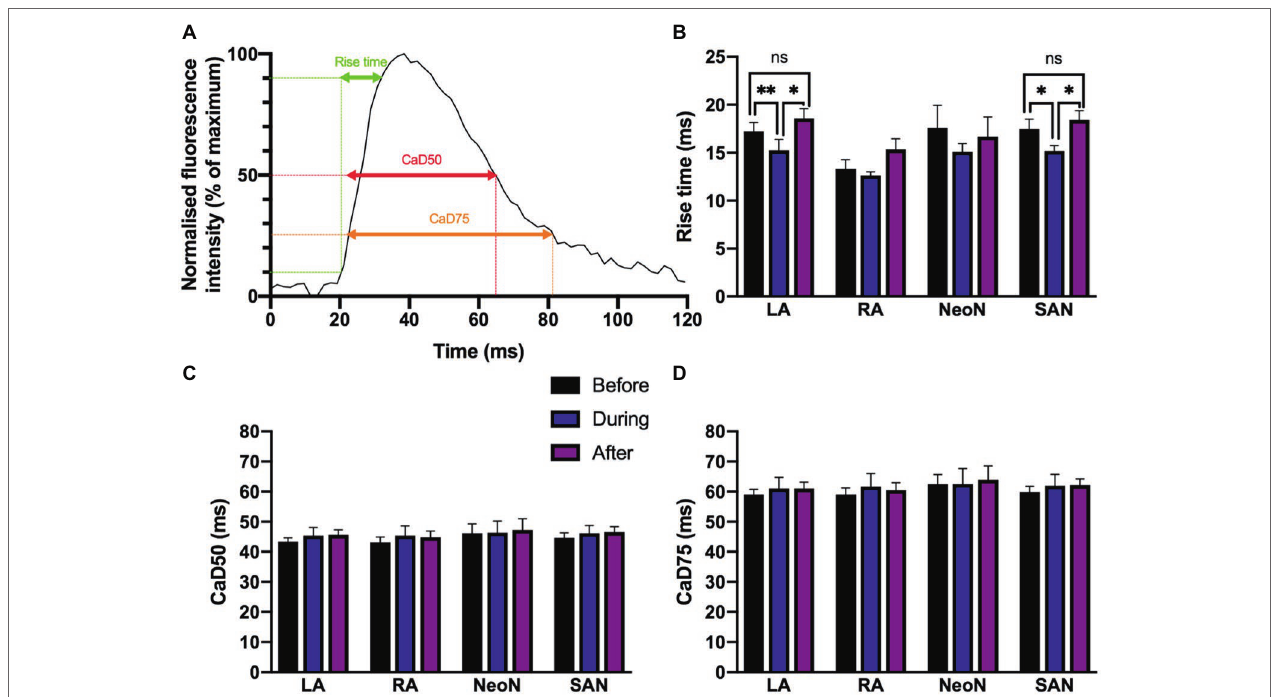
FIGURE 7 | (A) Characteristics of Ca 2+ transients recorded from different regions under sinus rhythm and optogenetic pacing. Representative Ca 2+ transient illustrating rise time; CaD50 (Ca 2+ transient duration to 50% of the decay); and CaD75 (Ca 2+ transient duration to 75% of the decay). CaD50 and CaD75 are calculated from max. dF/dt (max. upstroke) as detailed in the protocol. (B) Mean rise time, before ( n = 7), during ( n = 7), and after ( n = 6) optogenetic pacing. Key at center. Grouping is by region: LA, left atrium; RA, right atrium; NeoN, neonodal region ( n = 4); SAN, nodal region. (C) Mean CaD50 values, no overall